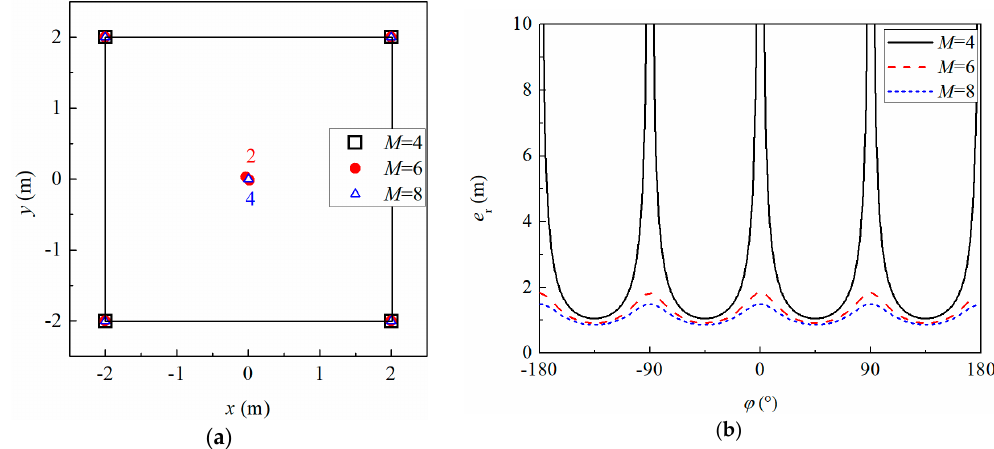
Figure 7. Optimization results for rectangular constraint areas with different numbers of antennas: ( a ) array deployment; ( b ) Cramér-Rao lower bound (CRLB) curve.